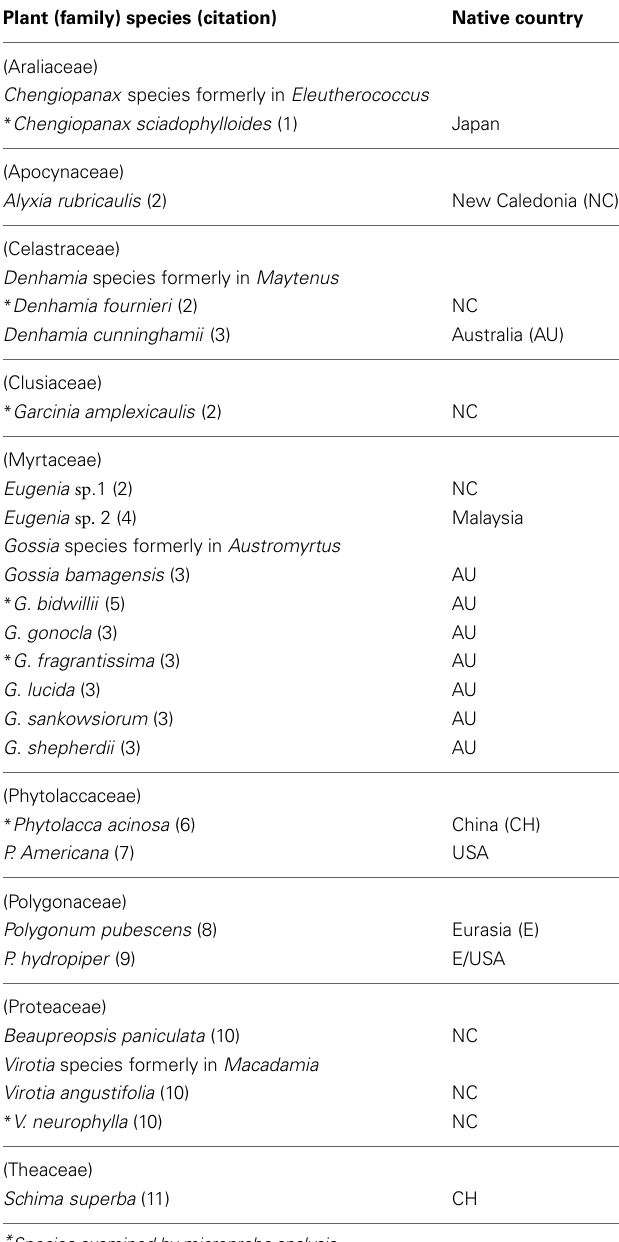
Table 1 | Current worldwide listing of Mn